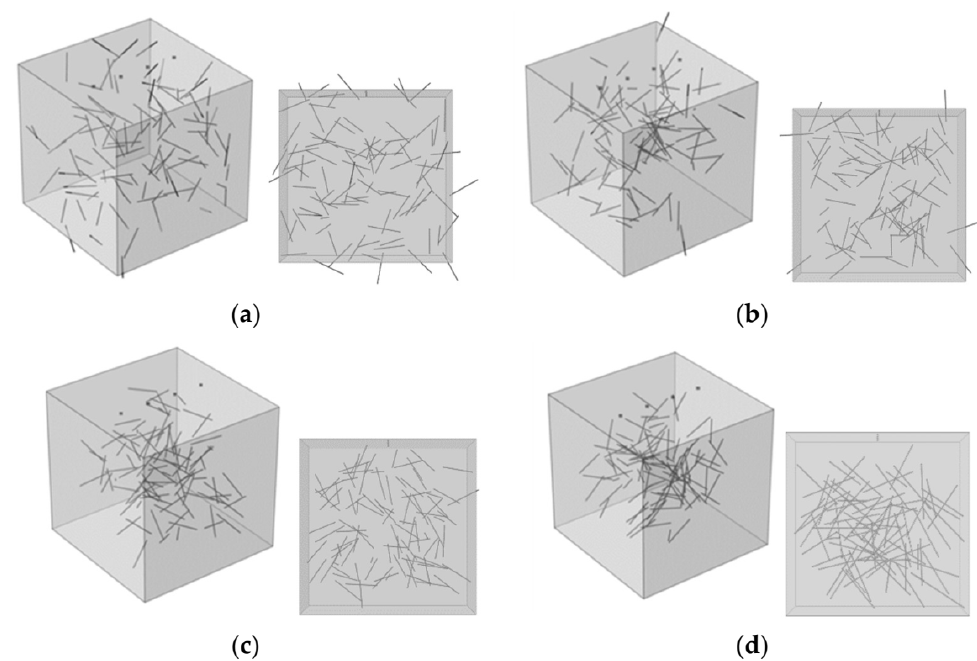
Figure 5. Models with carrying clear margins of ( a ) 0, ( b ) 10, ( c ) 20, and ( d ) 30 mm, after [46].